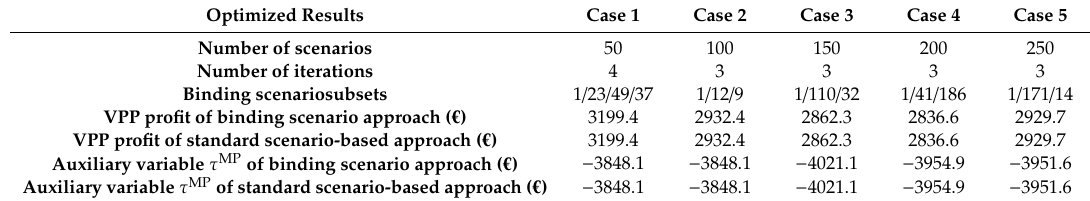
Table 2. Comparison of the solutions obtained using the binding scenario identification approach and the standard scenario-based approach [32] for the stochastic adaptive robust VPP dispatch